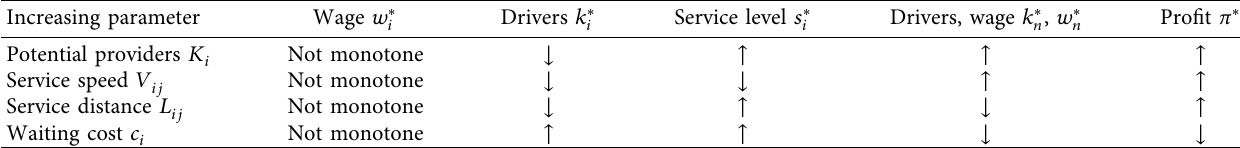
Table 1: Summary of sensitivity analysis in Proposition